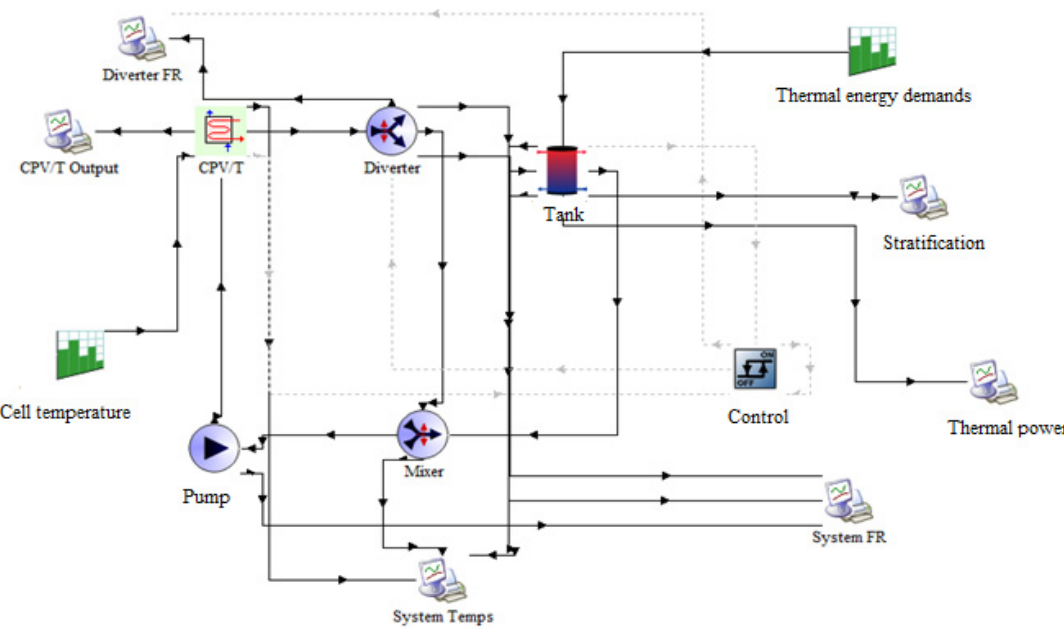
Figure 4. Scheme of the TRNSYS model.